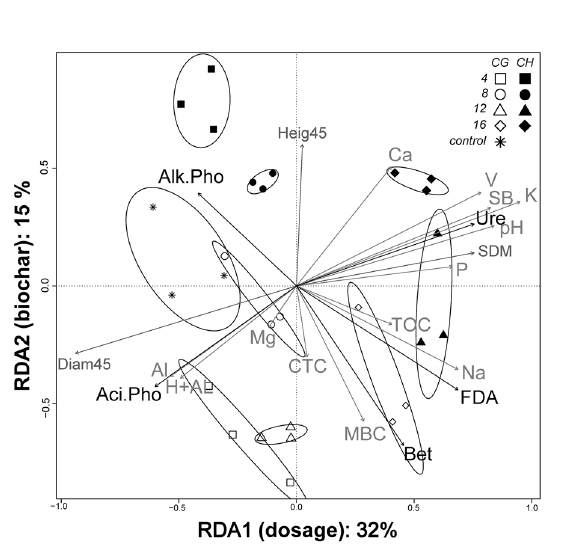
Figure 1. Redundancy analysis (RDA) among enzymatic activity, chemical and microbiological attributes of sandy Entisol cultivated with beans and treated with biochars of coffee grounds (CG) and coffee husks (CH) in Northeastern Brazil. Bet= β-Glucosidase; Ure= urease; Alk. Pho= alkaline phosphatase; Aci. Pho= acid phosphatase; FDA= fluorescein diacetate; MBC= microbial biomass carbon; TOC= total organic carbon; Heig45= Height; Diam 45= Diameter; SDM= shoot dry